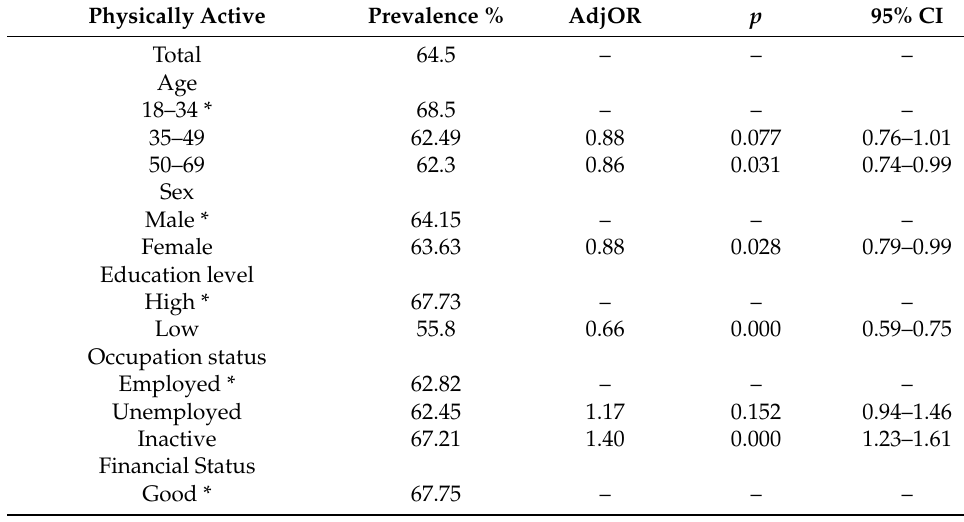
Table 4. Multivariate logistic regression analysis: predictors of eating at least 3 portions of fruits/vegetables per day (the logistic regression model includes all the covariates in the table); AdjOR: Adjusted Odds Ratio; CI: Confidence Interval; HL: Health Literacy. Physically